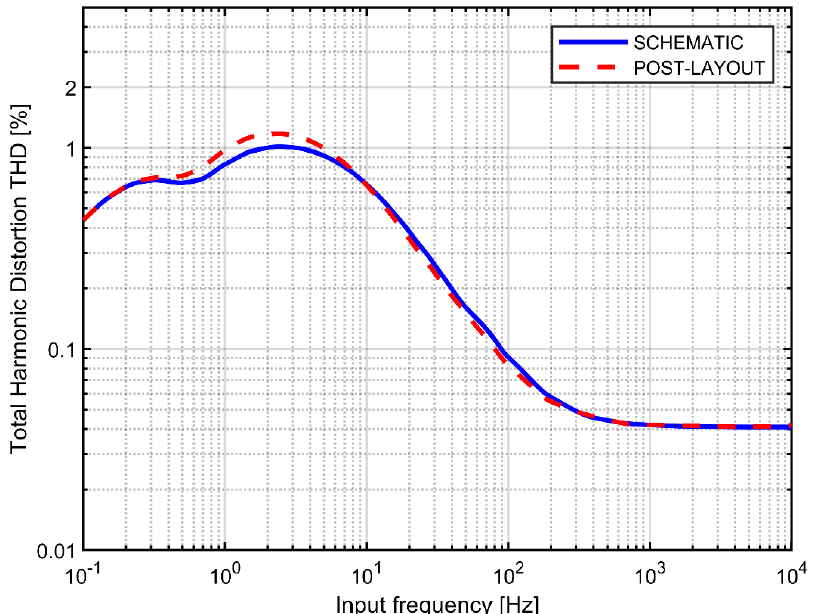
Figure 14. Simulated THD versus signal frequency for the complete AC-coupled preamplifier. Signal amplitude: 10 mV pp , cutoff frequency 1 Hz.